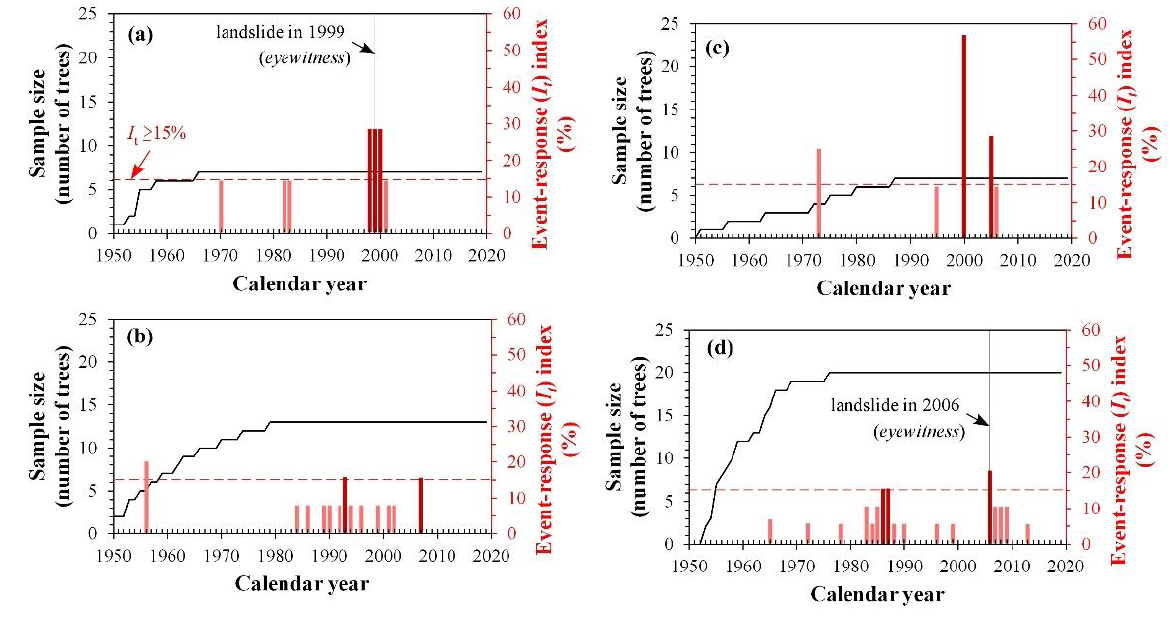
Figure 7. Dendrochronological investigations of past landslide events (dark red columns) expressed using the I t index and number of disturbed trees. ( a ) Chronology of the N-Ohkawa landslide. ( b ) Chronology of the eastern section of the Ohkawa landslide. ( c ) Chronology of the northern section of the Ohkawa landslide. ( d ) Chronology of the southern section of the Ohkawa landslide.